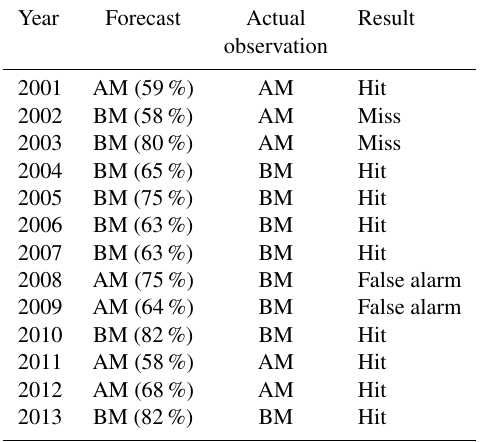
Table 2. The results of the k -NN generated CDI forecasts, including the most likely category (AM = Above Mean, BM = Below Mean) along with the corresponding k -NN assigned probability value ex- pressed as a percentage in parentheses next to it (column 2), the category in which the observed anomaly value resides (column 3) and the hit/miss/false alarm designations corresponding to these re- sults (column 4).